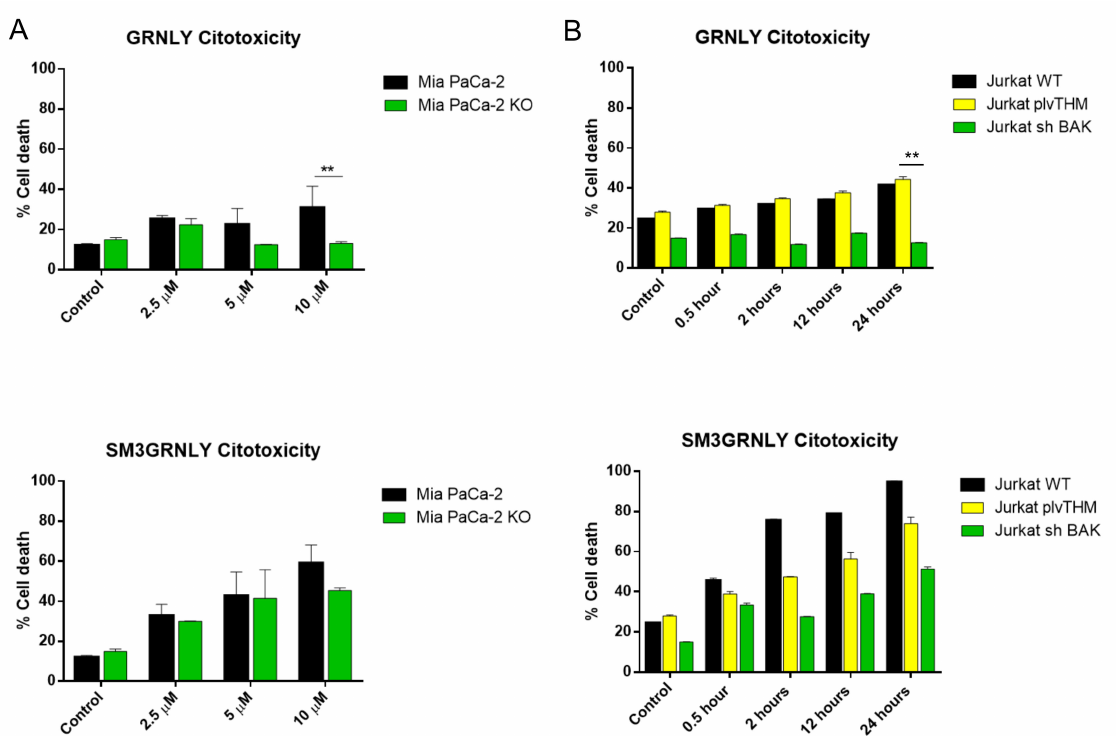
Figure 7. Dose-response cytotoxicity assays of GRNLY and SM3GRNLY on MIA PACA-2 and MIA PACA-2 KO cells ( A ) or on Jurkat, Jurkat-plvTHM and Jurkat-shBak cells ( B ). ( A ) cells were incubated with increasing concentrations of recombinant GRNLY (upper panel) or of SM3GRNLY (lower panel) for 24 h; ( B ) cells were incubated with a 10 µ M concentration of GRNLY (upper panel) or of SM3GRNLY (black bars) during the times indicated. After the incubations, cell death was determined by detecting PS exposure by Annexin-V-FITC ( A ) or Annexin V-DY63 ( B ) labeling and analysis of cell size by FSC. Results are the mean ± SD of three independent experiments; ** p <